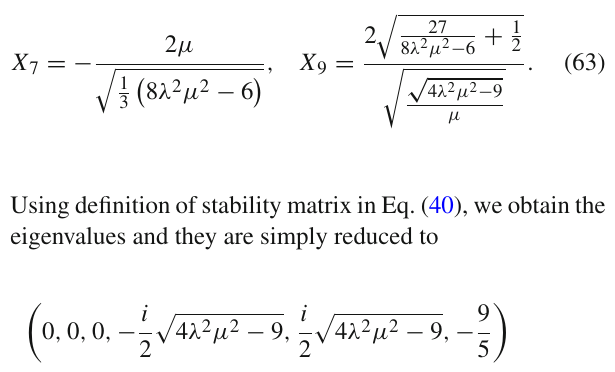
and (cid:12) ρ , m 1